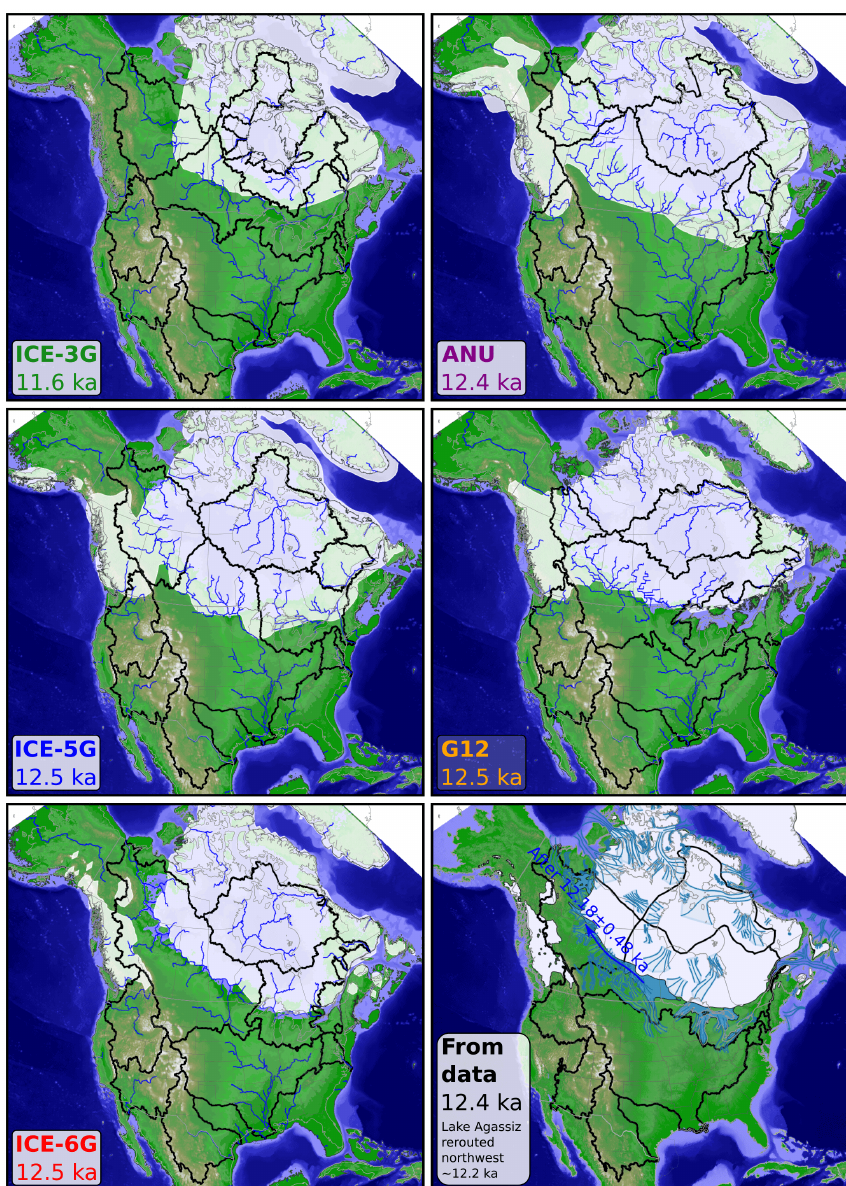
Figure 9. Younger Dryas (at the transition to the Holocene for ICE-3G). The Younger Dryas was a period of rapid cooling that corresponds with meltwater rerouting away from the Mississippi (e.g., Williams et al., 2012; Wickert et al., 2013) and enhanced meltwater output to the Mackenzie (Murton et al., 2010; Keigwin and Driscoll, 2014) and Saint Lawrence (e.g., Carlson et al., 2007a; Cronin et al., 2012) rivers. Model predictions here vary widely, but all successful ice-sheet reconstructions should at least match the extensively researched continental- scale drainage rerouting away from the Mississippi Basin starting at 12.9ka. Recent research indicates that outflow from Lake Agassiz, at the center of the continent, was first routed towards the Saint Lawrence and later ( ∼ 12.2ka: Breckenridge, 2015) routed towards the Mackenzie River (Sect.